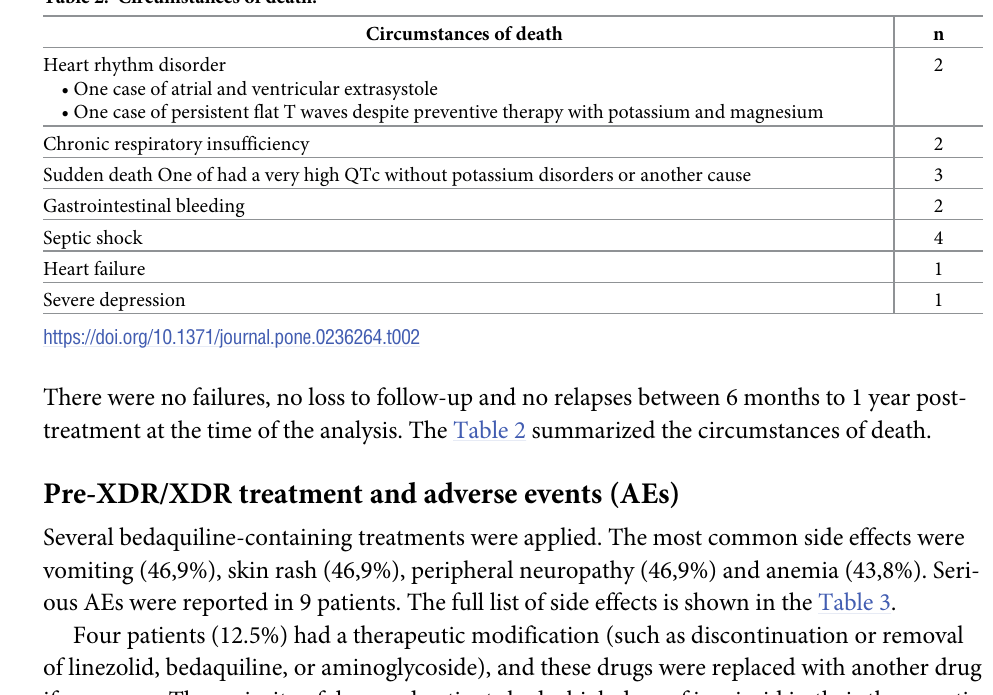
Table 2. Circumstances of death.